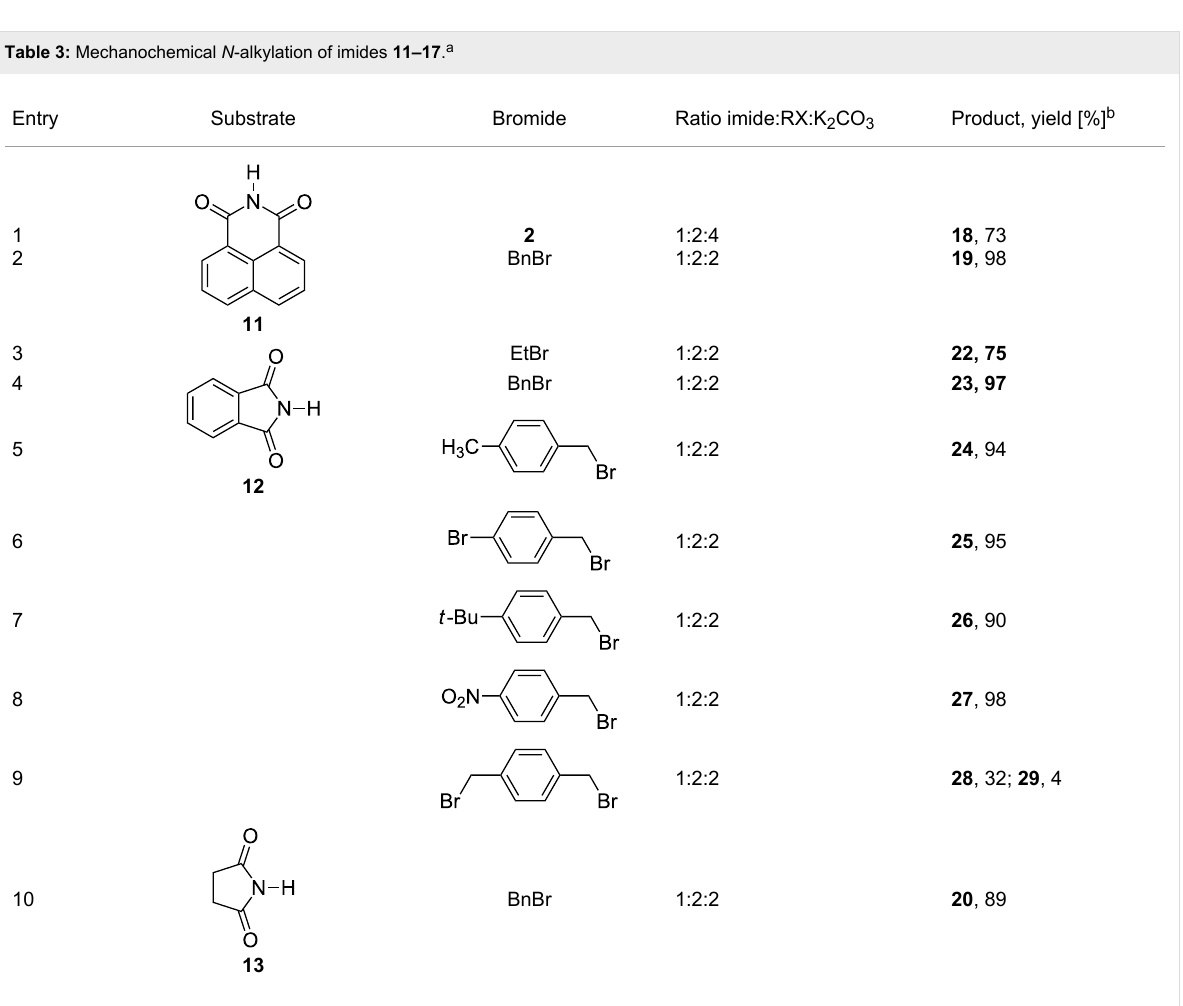
Figure 1: Products of alkylation of imides 11 – 17 .